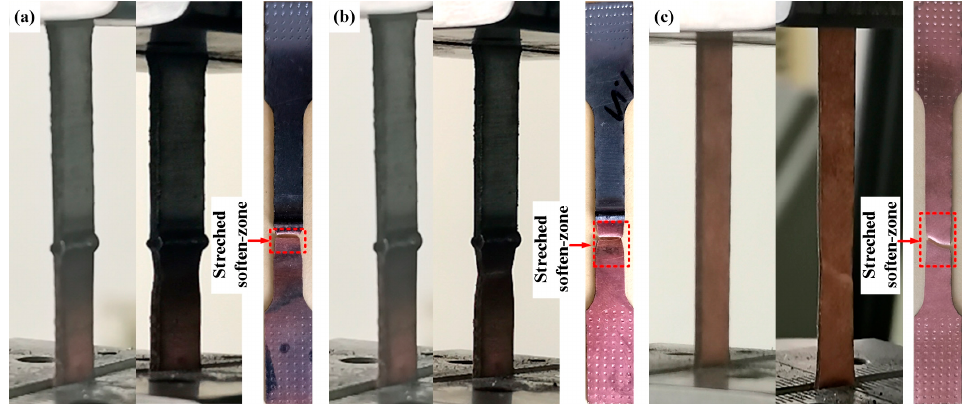
Figure 14. The specimens of the joints mounted on the testing machine at the beginning of the test, during the test and at the end: ( a ) specimen of 600 alloy filled joint; ( b ) specimen of ERNiCu-7 filled joint; and ( c ) specimen of pure Cu.